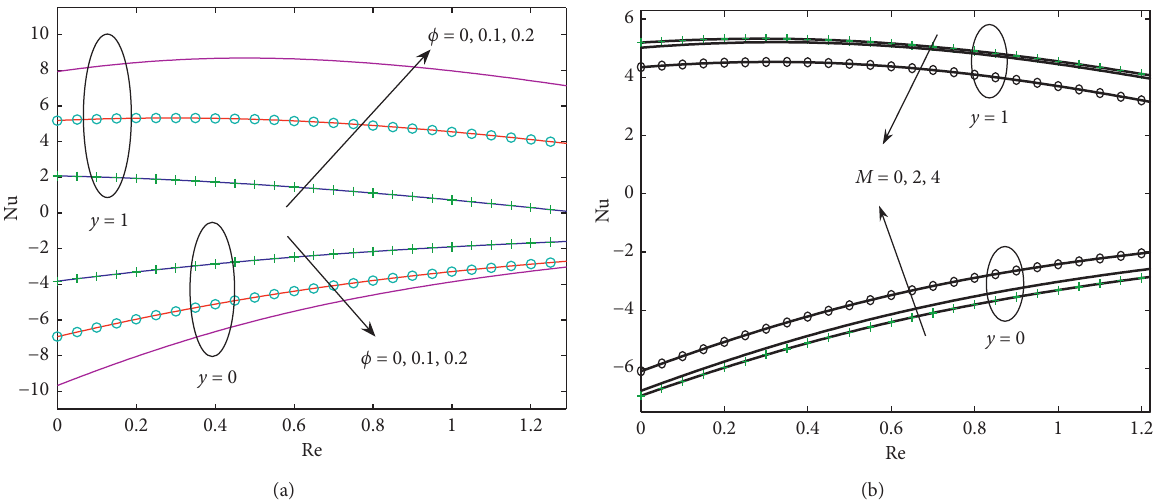
Figure 8: Nusselt number distribution for t � π /4 , ε � 0 . 01 , H � 3 , β � 2 , Ec � 1 , Da � 0 . 1 , Rd � 2 , Re � 1 , andPr � 21 , Q � 0 . 5. (a) Effect of ϕ when M � 0 . 5, and (b) effect of M when ϕ � 0 .